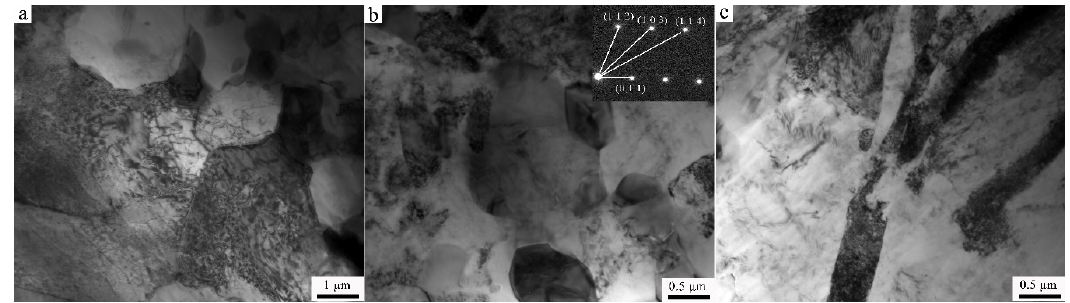
Figure 3. TEM images of Ex-AZ91-free alloy ( a ) refined grain with higher dislocation, ( b ) β phase, and ( c ) twins.